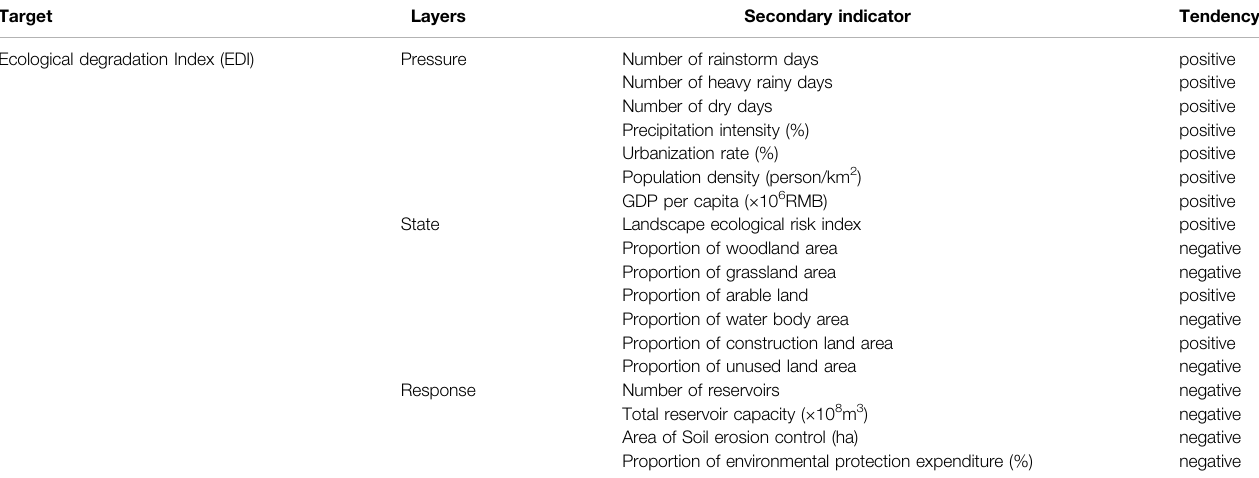
TABLE 1 | Selection of indicators for ecological degradation assessment in the Yellow River